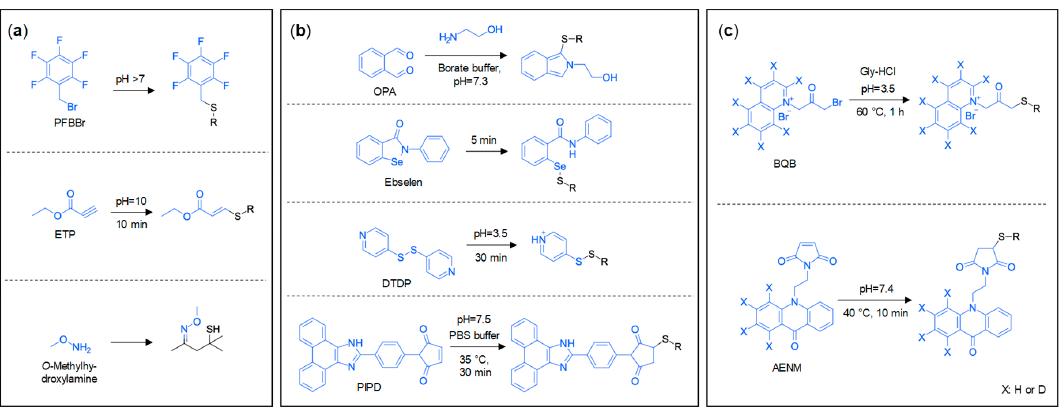
Figure 2. Derivatisation reagents and reactions of volatile thiols in wine, foods, and other beverages for ( a ) gas chromatography (GC) analysis, ( b ) liquid chromatography (LC) analysis, and ( c ) LC with stable isotope labelled derivatisation reagents. PFBBr: 2,3,4,5,6-pentafluorobenzyl bromide; ETP: ethyl propiolate; OPA: o -phthaldialdehyde; ebselen: 2-phenyl-1,2-benzisoselenazol-3(2H)-one; DTDP: 4,4'-dithiodipyridine; PIPD: 1-(4-(1 H -phenanthro[9,10-d]imidazol-2-yl)phenyl)-1 H -pyrrole-5-dione; BQB: ω -bromoacetonylquinolinium bromide; AENM: acridone-10-ethyl- N -maleimide.